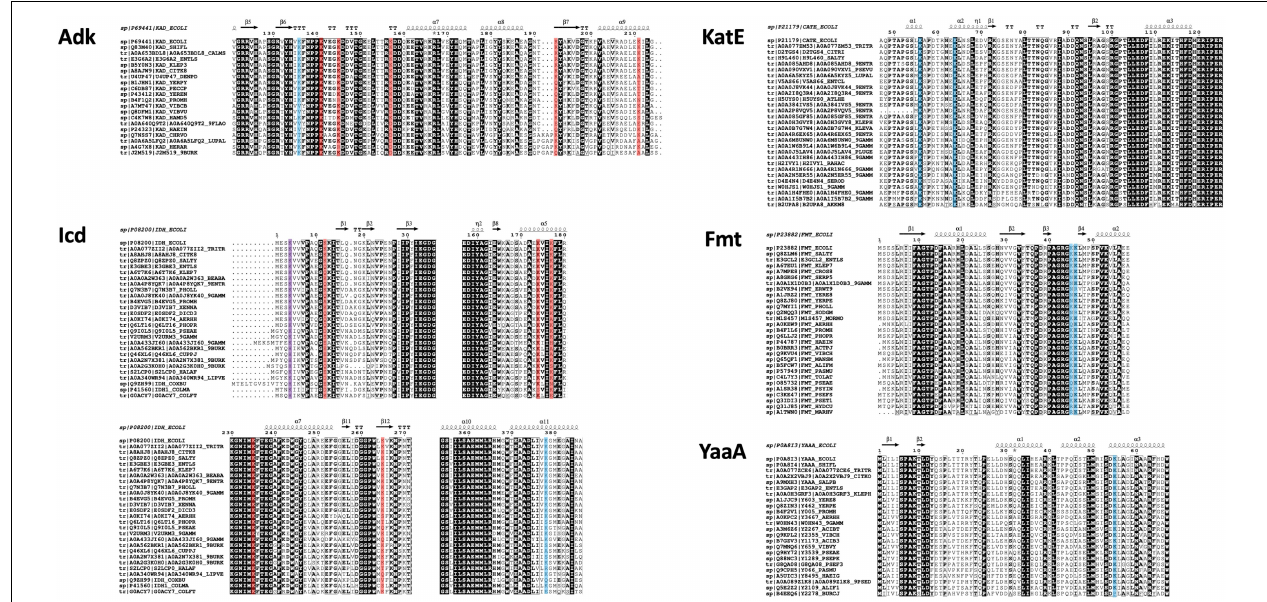
FIGURE 8 | Conservation of E. coli substrate protein (Adk, Icd, KatE, Fmt, and YaaA) acetylated lysine sites across homologs identified by sequence from UniProt. Sequences were cropped to only show regions containing acetylated sites in the E. coli proteins (blue highlighting indicates KAT acetylation sites, red indicates AcP acetylation sites, and purple indicates both AcP and KAT acetylation sites). UniProt IDs for each protein are listed adjacent to each sequence and the E. coli substrate protein sequence and secondary structure of the target structure used in our comparative analysis is shown on top (PDB ID: 1ake for Adk, PDB ID: 1ai2 for Icd, PDB ID: 1cf9 for KatE, PDB ID: 2fmt for Fmt, and PDB ID: 5caj). Sequences are ordered from highest to lowest percent sequence identity compared to the target protein: approximately 99–66% (Adk), 99–73% (Icd), 99–62% (KatE), 91–56% (Fmt), and 100–58% (YaaA). Complete sequence alignments and details about selected proteins are shown in Supplementary Figure 4 . See section “MATERIALS AND METHODS” for further